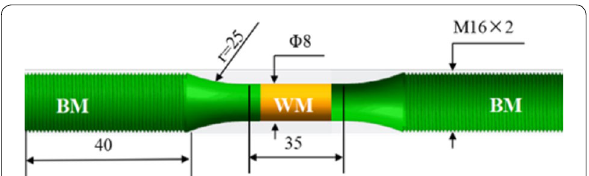
Figure 1 Geometry of the specimen for low cycle fatigue test (Unit: